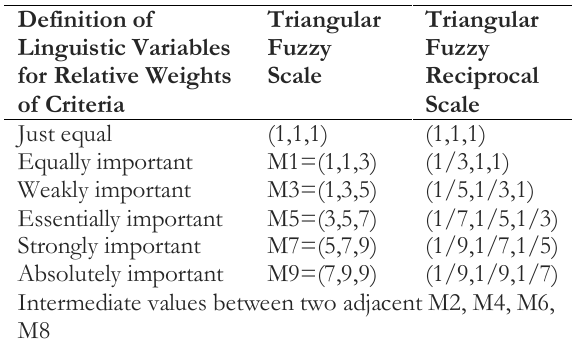
Table 2. Linguistic expression for fuzzy scale of relative weights of criteria.